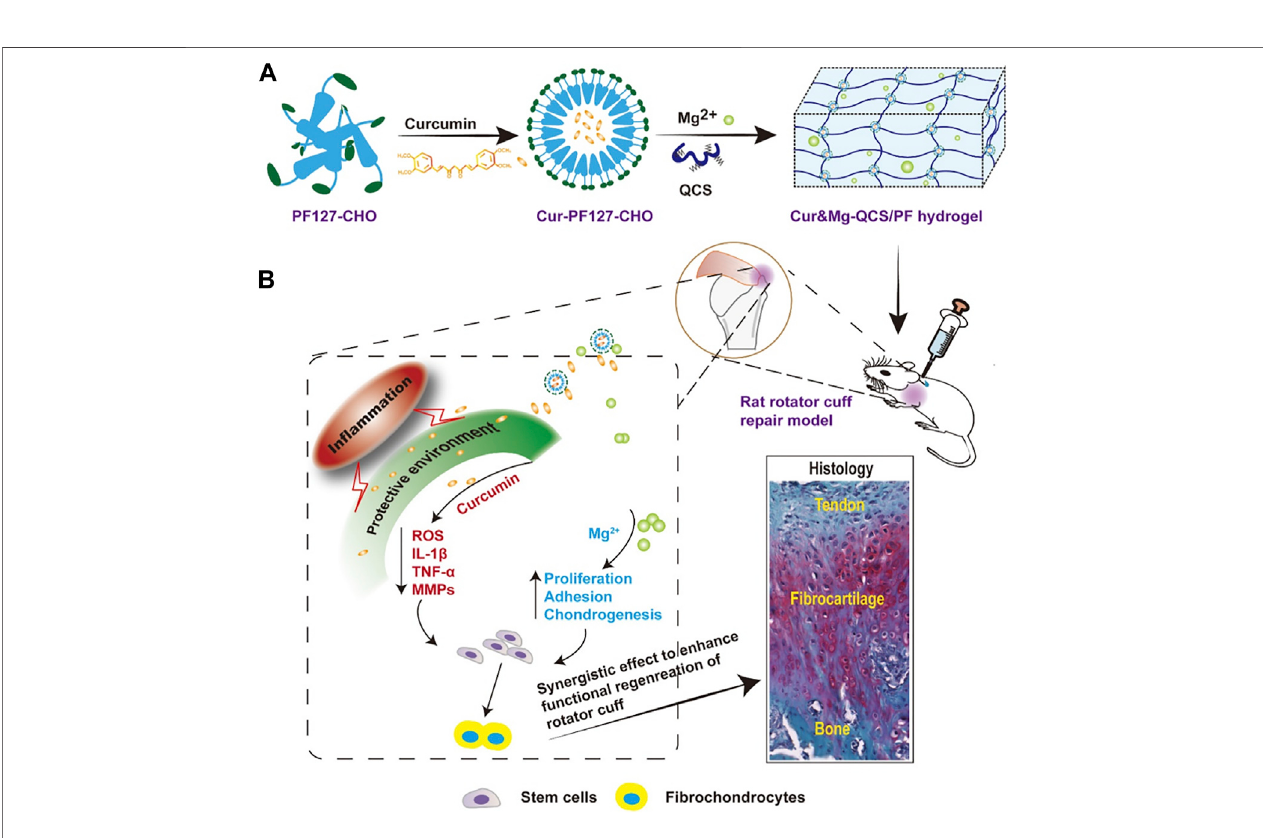
Frontiers in Bioengineering and Biotechnology |